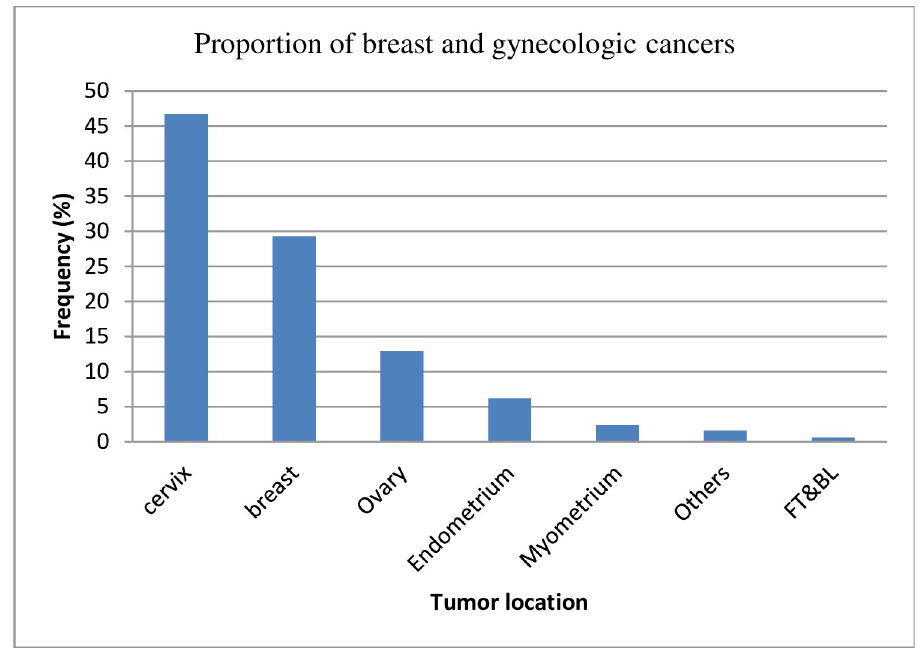
Fig 1. Proportional morbidity of breast and gynecological cancers among clients presenting at SPHMMC, 2014– 18. FT&LB: Fallopian tube and Broad ligaments.